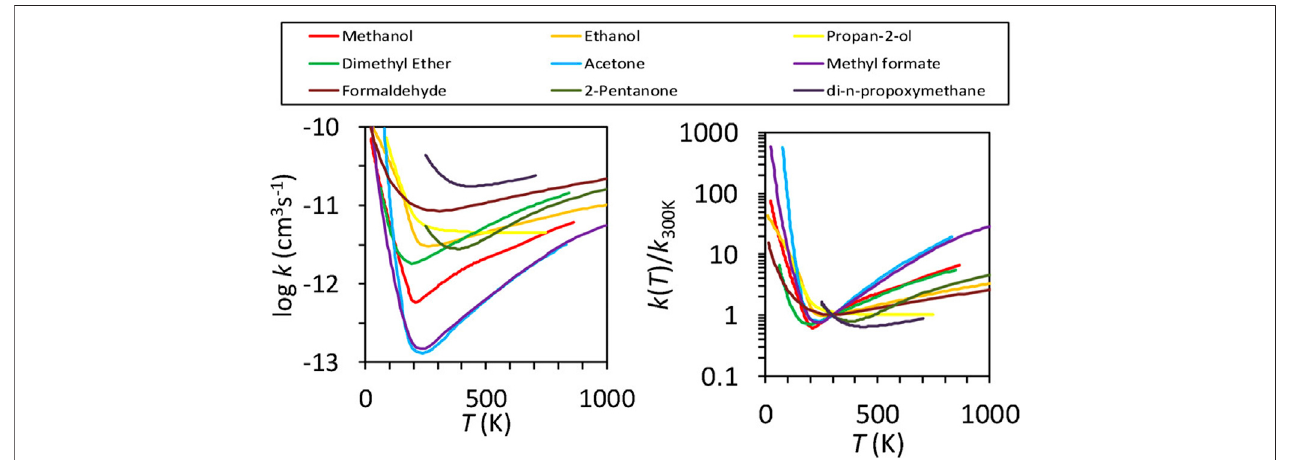
FIGURE 2 | Rate coef fi cients, k (left panel), and the ratio, k (T)/ k (300 K) (right panel), as functions of temperature for reactions of OH with assorted organic molecules. The lines, which show the “ U-shaped ” dependence of rate on temperature, are interpolated fi ts to literature data. Permission requested to reproduce this fi gure, which originally appeared as Figure 3 in Heard